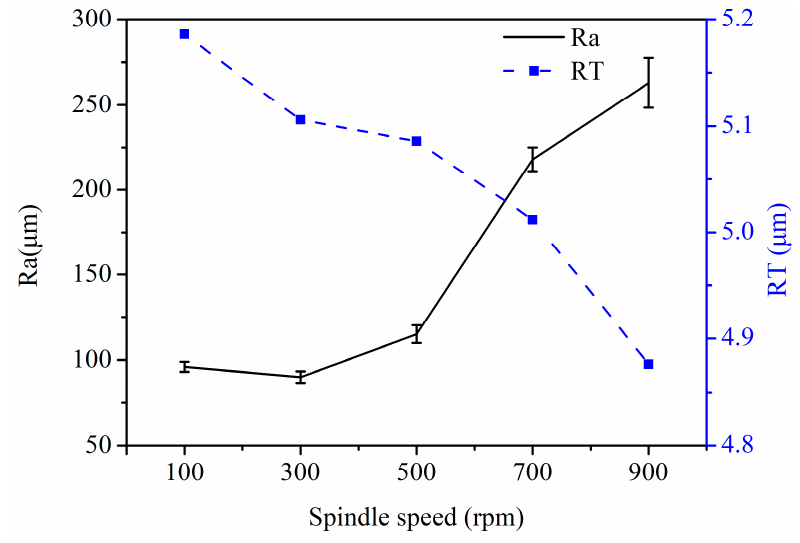
Figure 8. Graph of the effect of spindle speed on Ra and RT